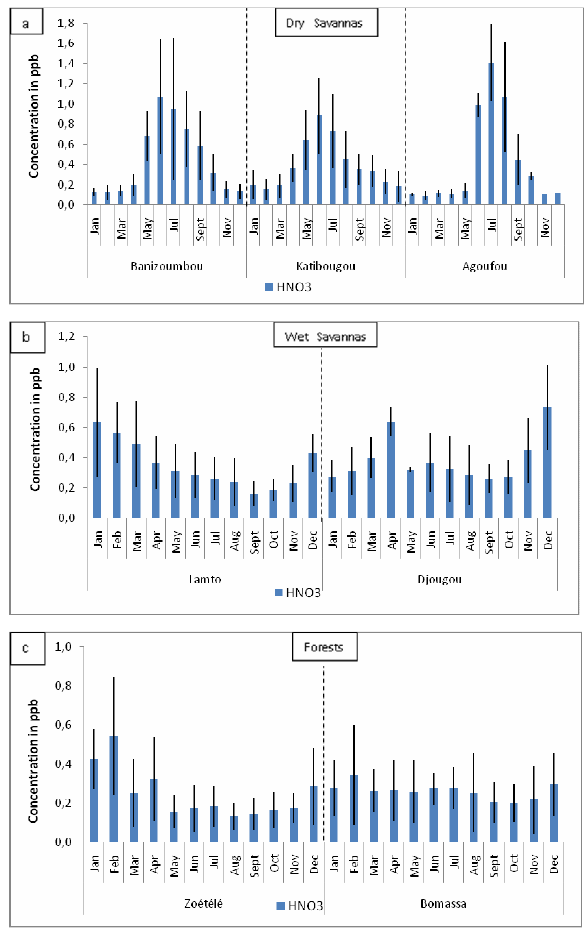
Figure 6 : Evolution of monthly HNO 3 concentrations on the transect dry savannas (6a), wet savannas (6b), forests (6c). Fig. 6. Evolution of monthly HNO 3 concentrations on the transect dry savannas (a) , wet savannas (b) , forests (c)